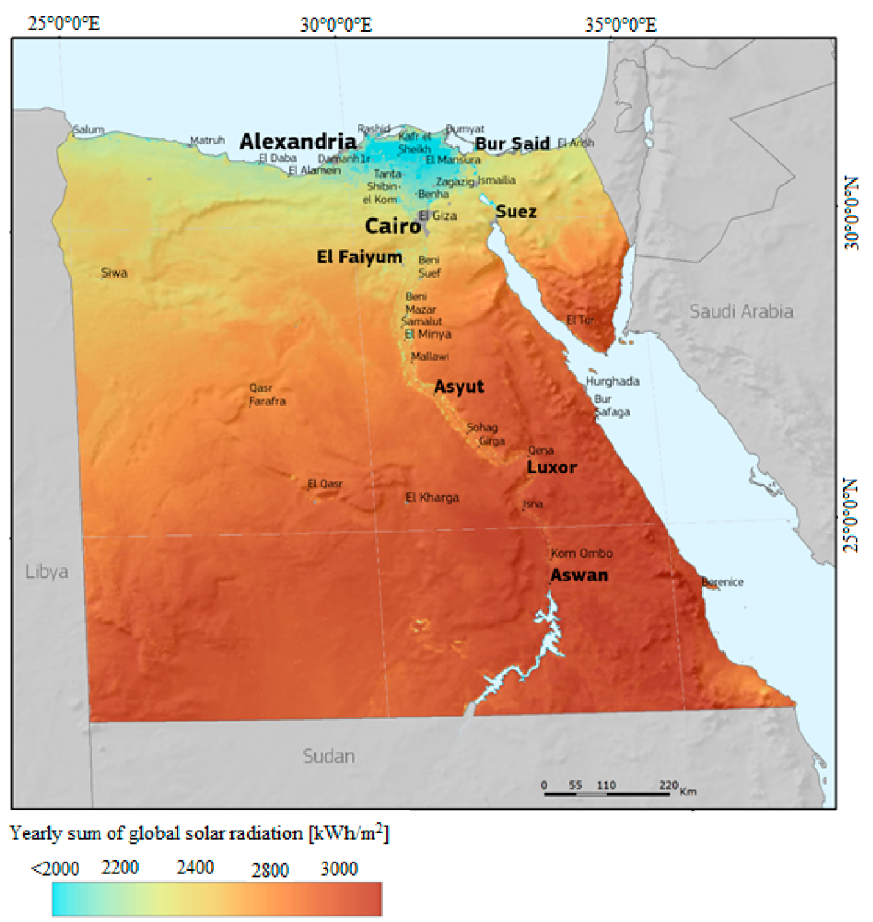
Figure 11. The global horizontal irradiation over the country of Egypt.